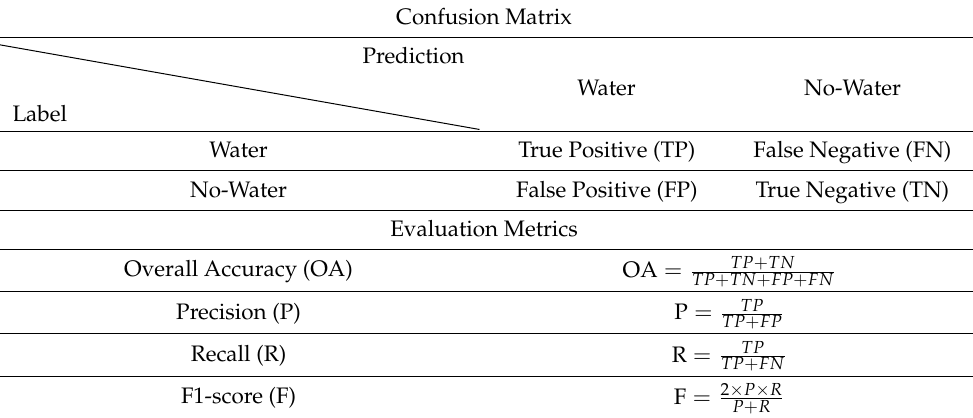
Table 2. Metrics used in performance evaluation of the deep learning models adopted in flood